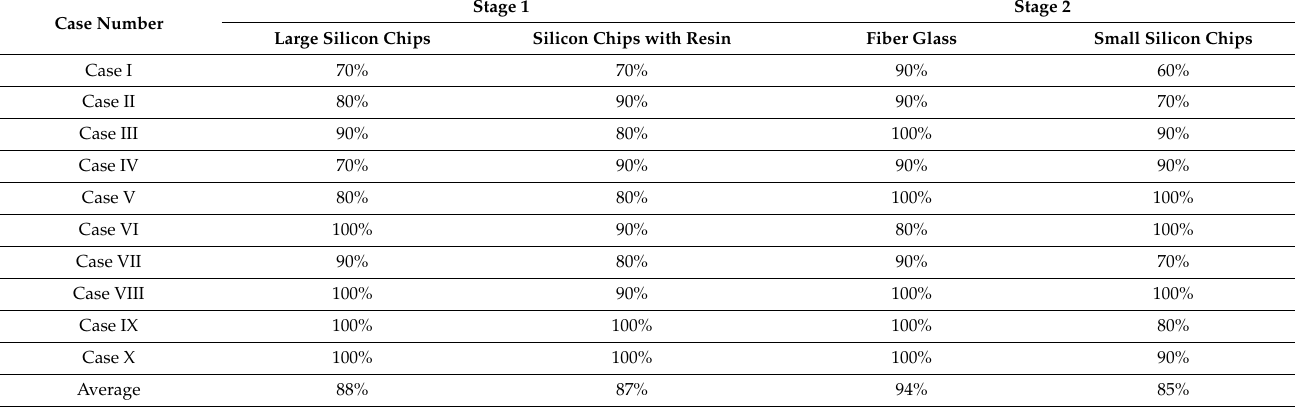
Table 2. Efficiency table of the sorting